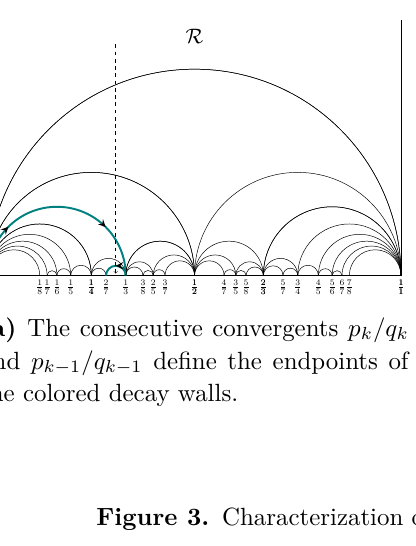
Figure 3. Characterization of the lines of marginal